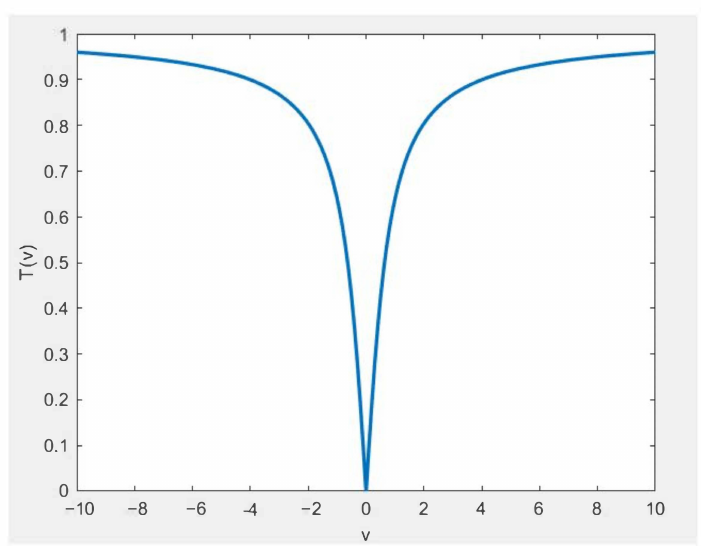
Figure 2. V-shaped transfer